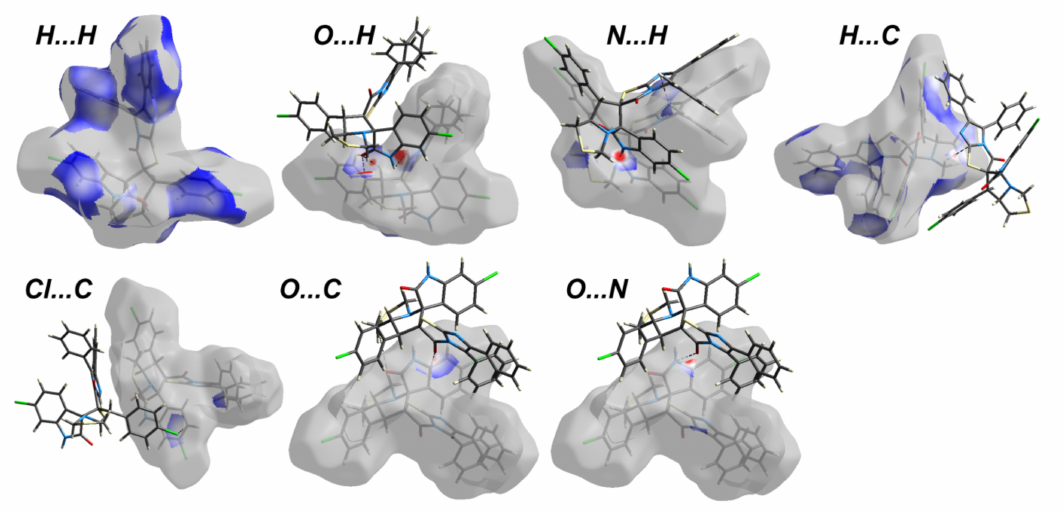
Figure 7. Decomposed d norm surfaces for the important interactions in 4 .